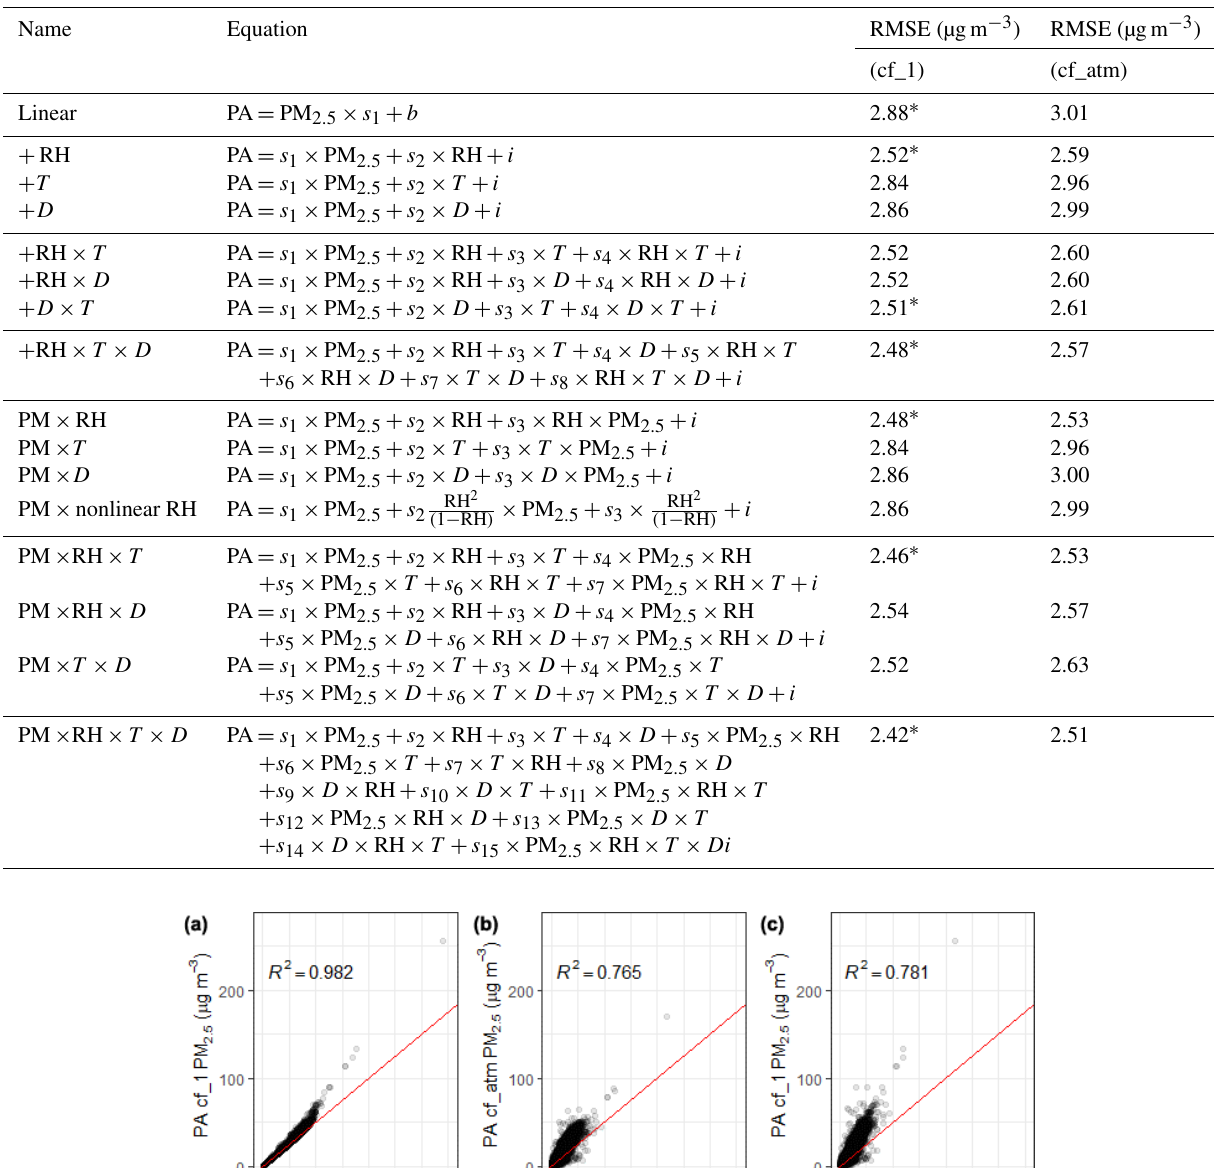
Table 2. Correction equation forms considered and the root mean square error (RMSE). The best-performing model from each increasing level of complexity (as indicated with ∗ ) was validated using withholding methods in the next sections (Sect. 5).